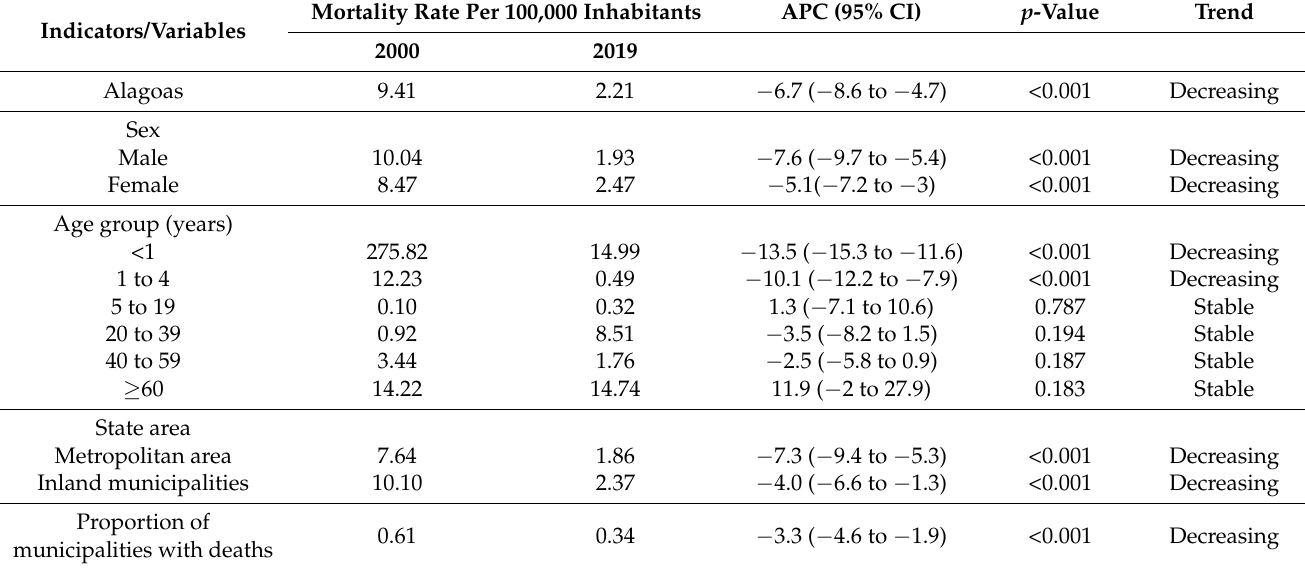
Table 2. Temporal trend of mortality rates from diarrhea and infectious gastroenteritis according to sociodemographic variables in the state of Alagoas, Northeast Brazil between 2000 and